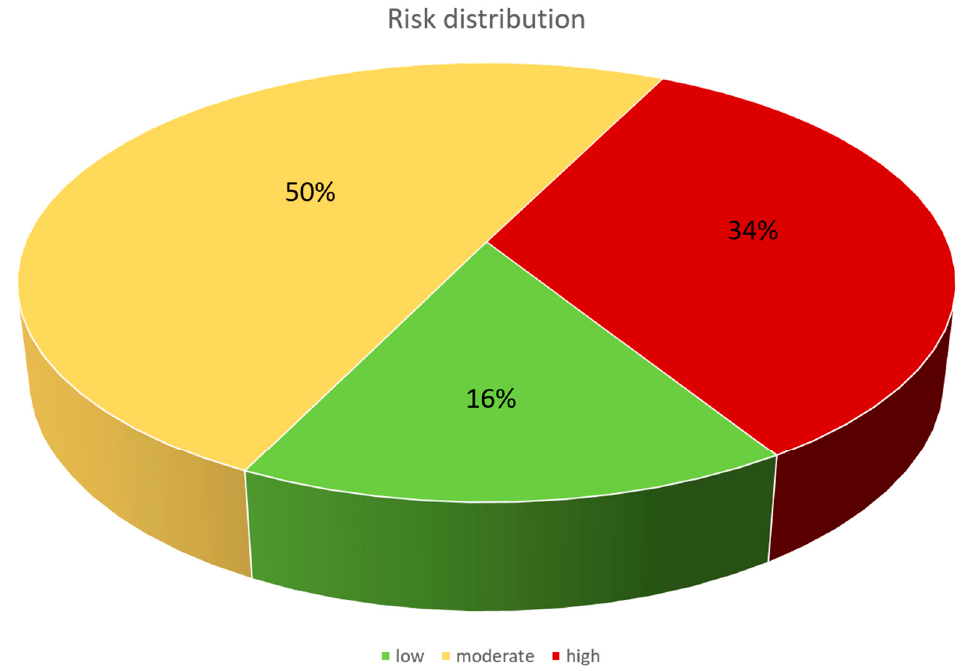
Figure 2. Distribution of the three risk groups, indicating a low, moderate or high risk for EP infections with oral origin.